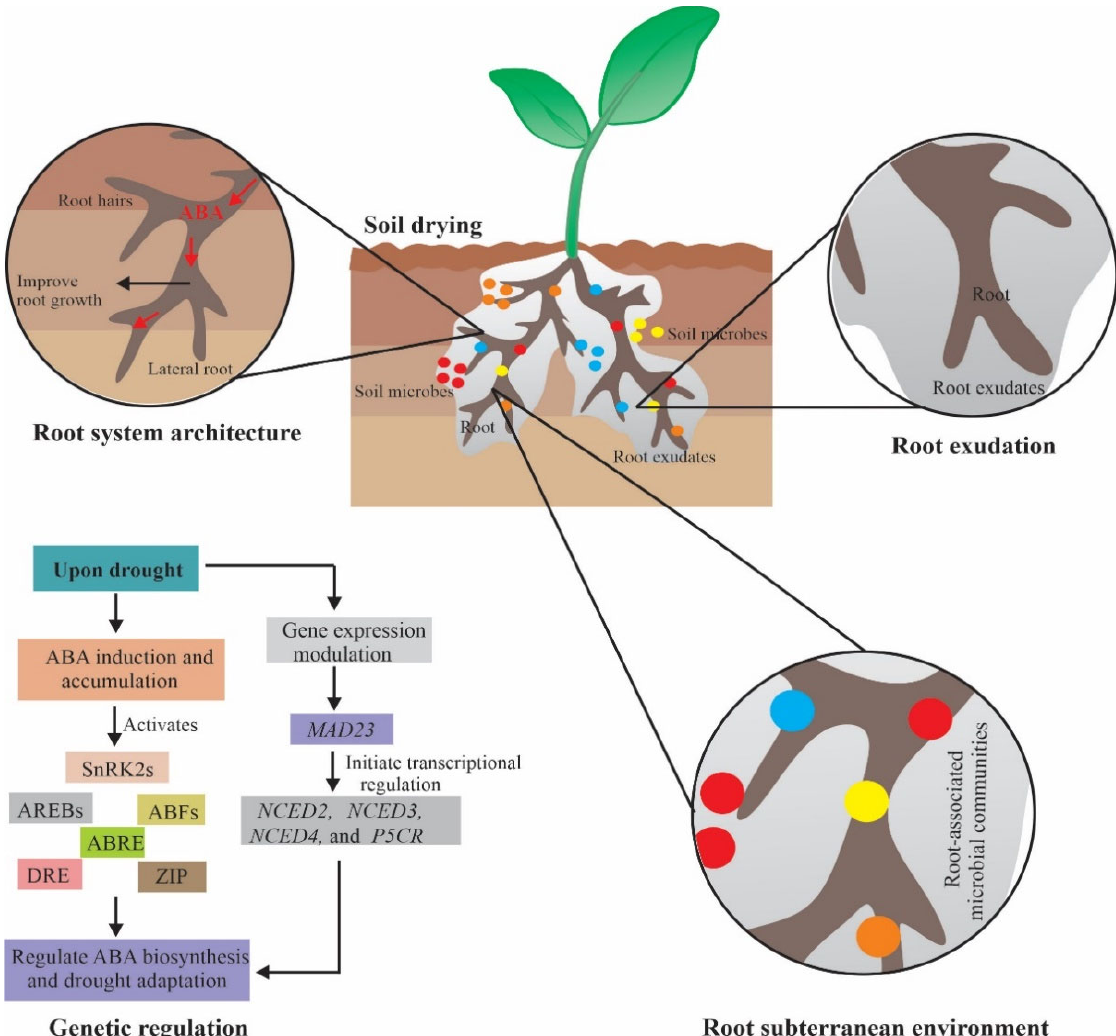
Figure 3. Role of ABA in mitigating drought tolerance at root system architecture that includes root exudates, microbial communities at the root-soil interface, and genetic and molecular regulation of various ABA-responsive genes and proteins. Endogenous ABA modulates the root system architec- ture by promoting root growth, soil microbial communities, and root exudation in response to soil drying. ABA accumulation upon drought led to the activation of TFs and modulates expression of genes responsible for improving ABA ‐ mediated drought tolerance.